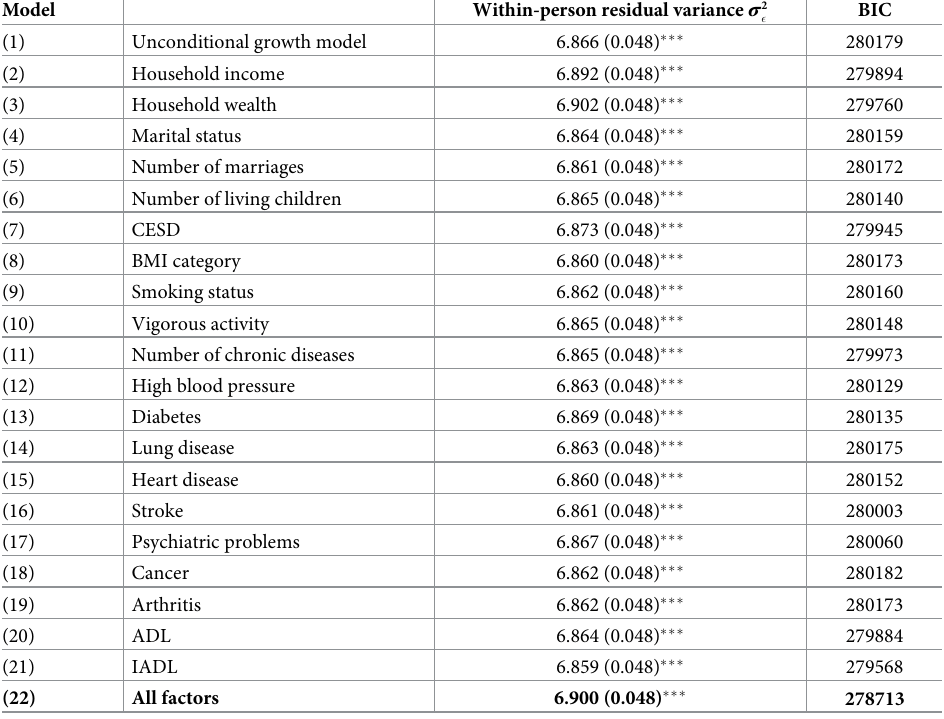
Table 4. Time-varying predictors of within-person change of cognitive functioning from multilevel linear growth models, health retirement study,